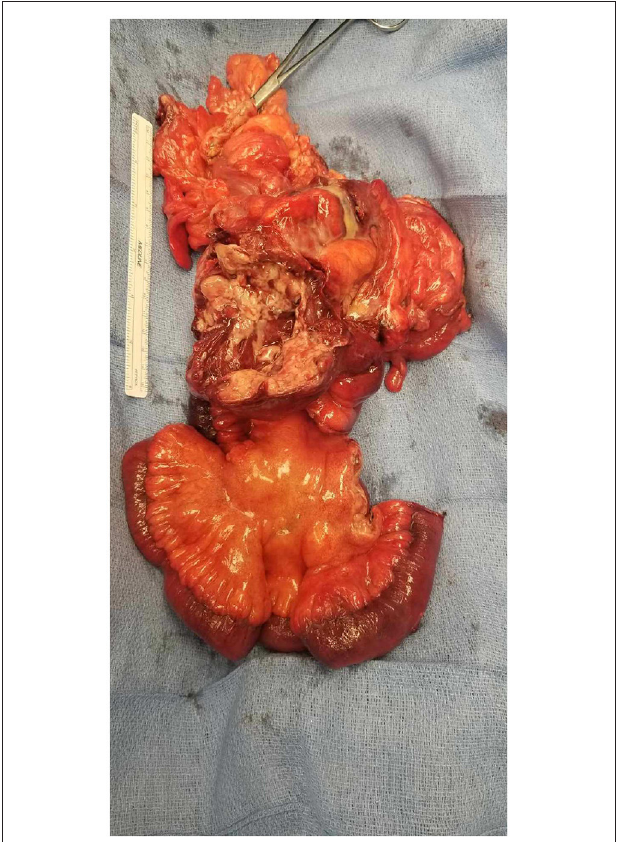
FIGURE 7 | Gross pathology demonstrating mass with intimate association to sigmoid colon with involved mesentery and ileum resection. Anterior view.